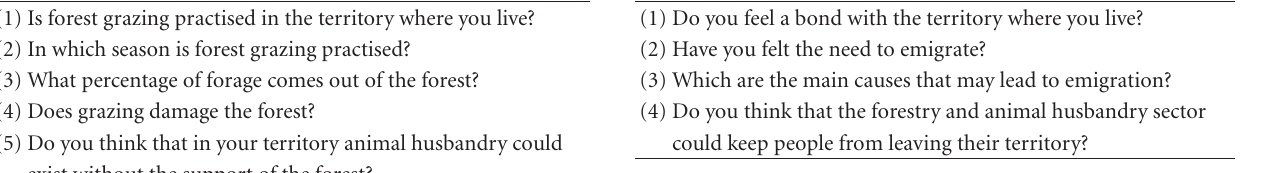
Table 2: Questions in Section 2.2.1. Table 3: Questions in Section 2.2.2.